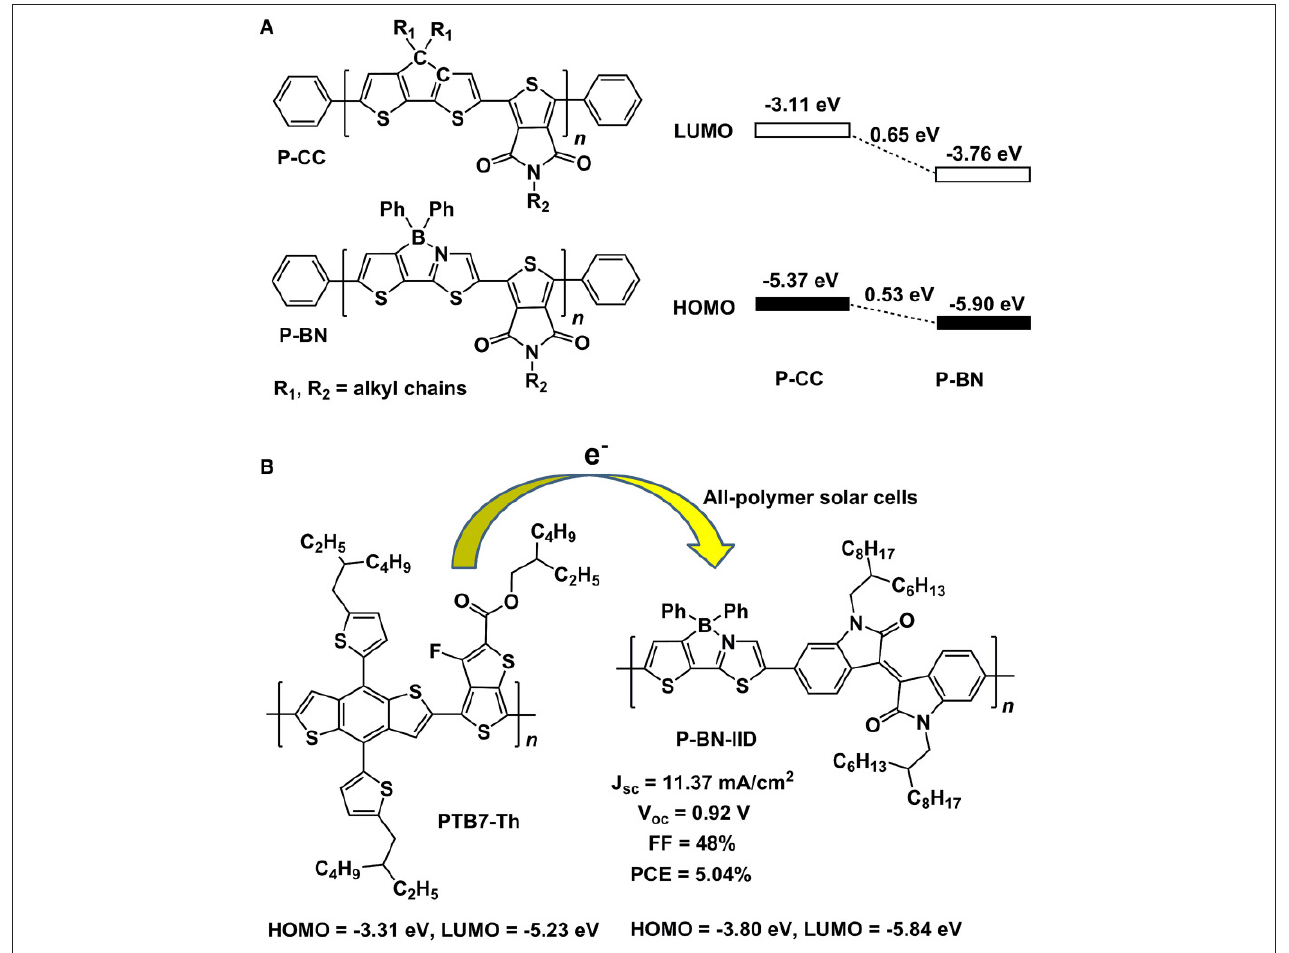
FIGURE 11 | Molecular structures of P-CC and P-BN and the alignment of frontier orbital energy levels (A) and parameters of all-polymer solar cells based on PTB7-Th and P-BN-IID (B)